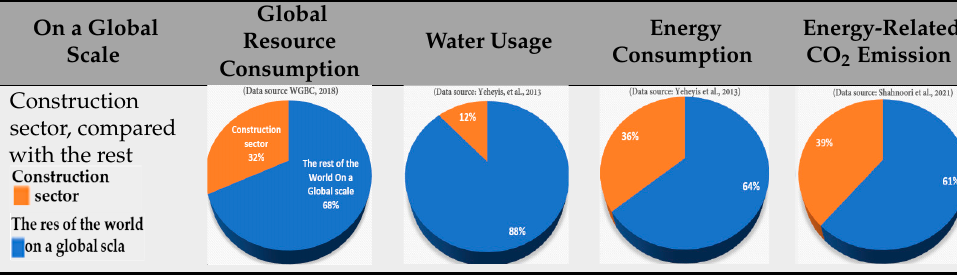
Table 1. Share of construction sector in impacts on Earth’s (or even Universe’s) environment.